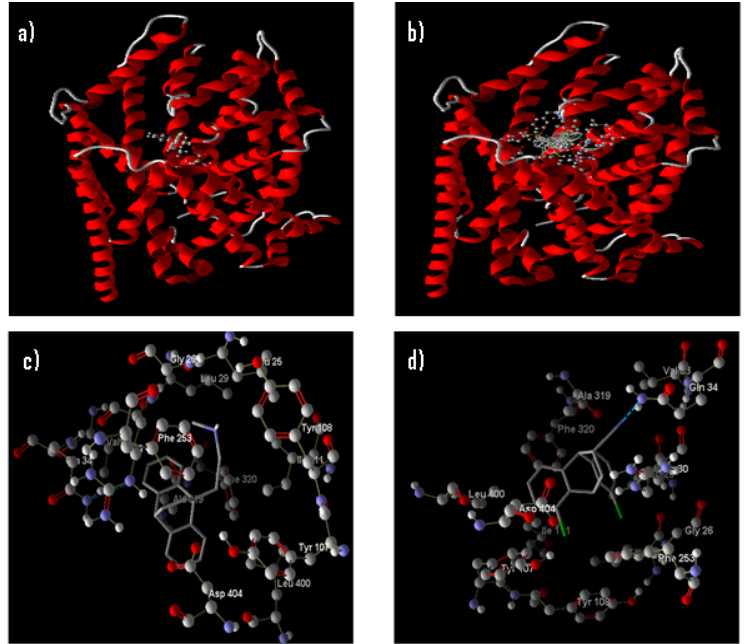
Figure 2. Structure of the 2QJU model complex with: ( a ) its ligand DSM, ( b ) 6 Anti , ( c ) pose of reference drug maprotiline 9 , ( d ) pose of compound 7 syn.